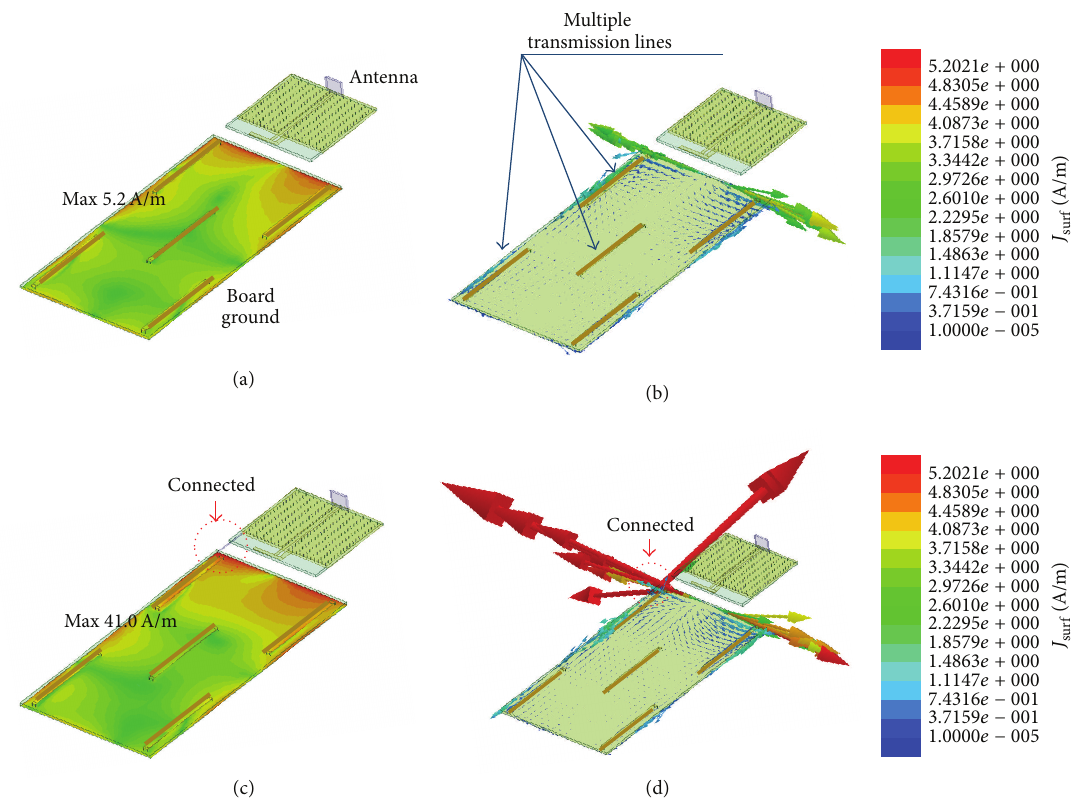
Figure 11: Induced current distribution on the ground with five vertical transmission lines: (a) current distribution with separate ground, (b) current vectors with separate ground, (c) current distribution with common ground, and (d) current vector with common